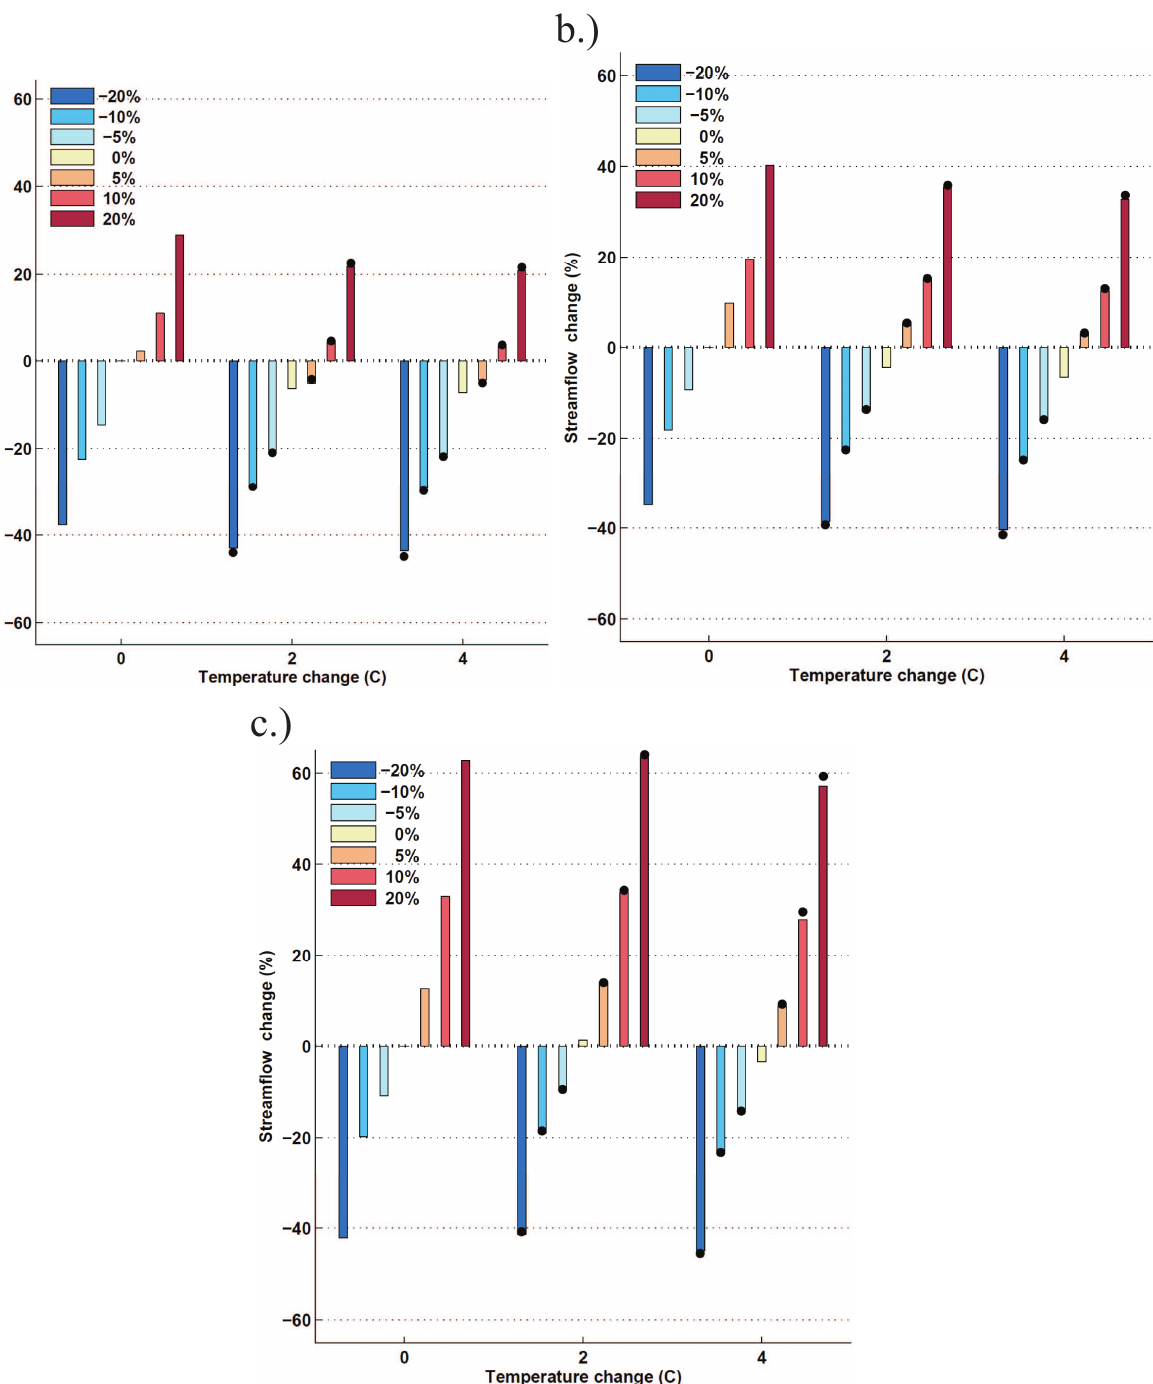
Figure 10: Change in annual streamflow (%) for different temperature and precipitation scenarios. a) Baro Akobo, b) Abbay and c) Tekeze. Black dots indicate the linear sensitivity estimate based on equation 3.3.